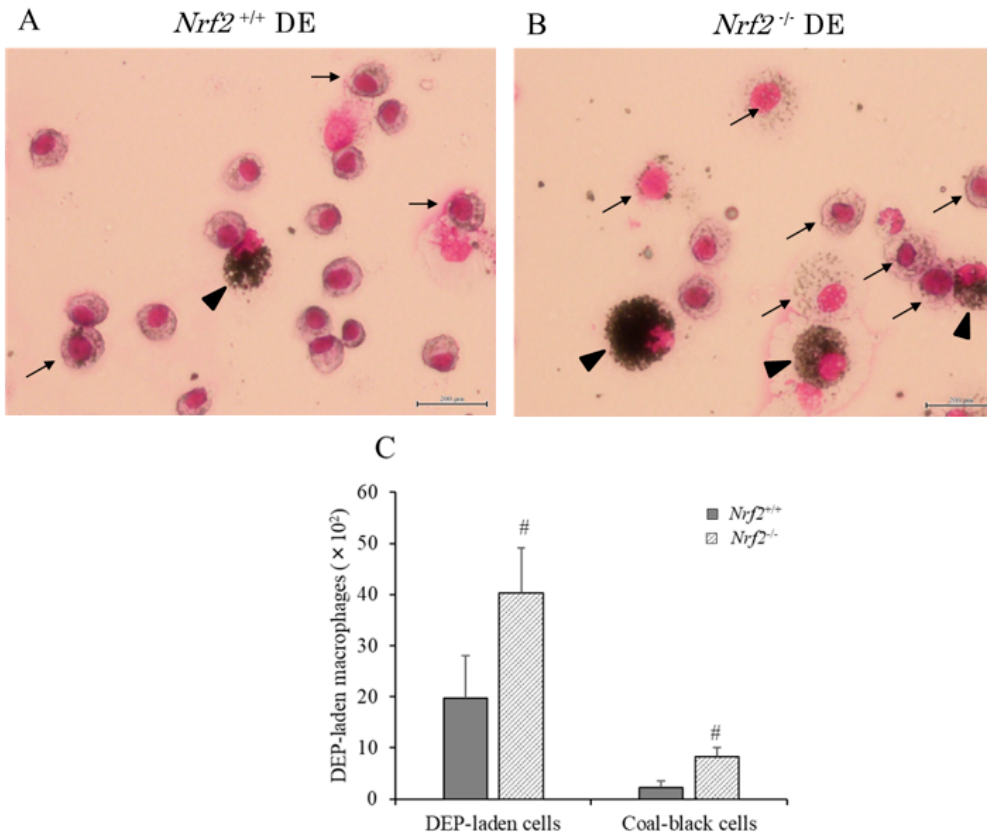
Figure 2. The pathologic features of diesel exhaust (DE) particles (DEP)-laden alveolar macrophages in BALF. ( A ) DE group in Nrf2 +/+ mice; ( B ) DE group in Nrf2 − / − mice. Representative optical micrographs of May–Giemsa (Kobe, Japan) stained cell preparations. Scale bar was 200 µ m. Arrows indicate DEP-laden alveolar macrophages. DEP-laden macrophages in which DEP accounted for more than half of the cytoplasm were defined as coal-black cells. Arrowhead indicates coal-black alveolar macrophages. ( C ) Percentages of DEP-laden macrophages and coal-black alveolar macrophages in total macrophages. Data are shown as mean ± SD values in each group ( Nrf2 +/+ DE: n = 6; Nrf2 − / − DE: n = 5), # p < 0.05 vs. Nrf2 +/+ .